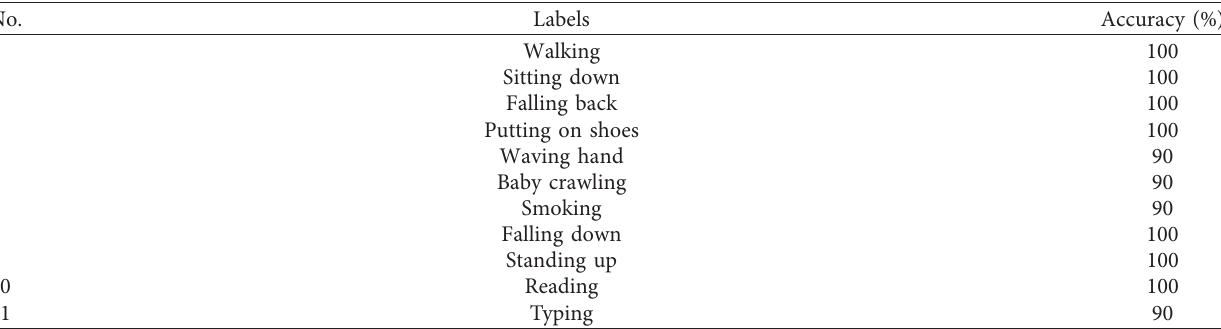
Table 3: Tensorflow results.